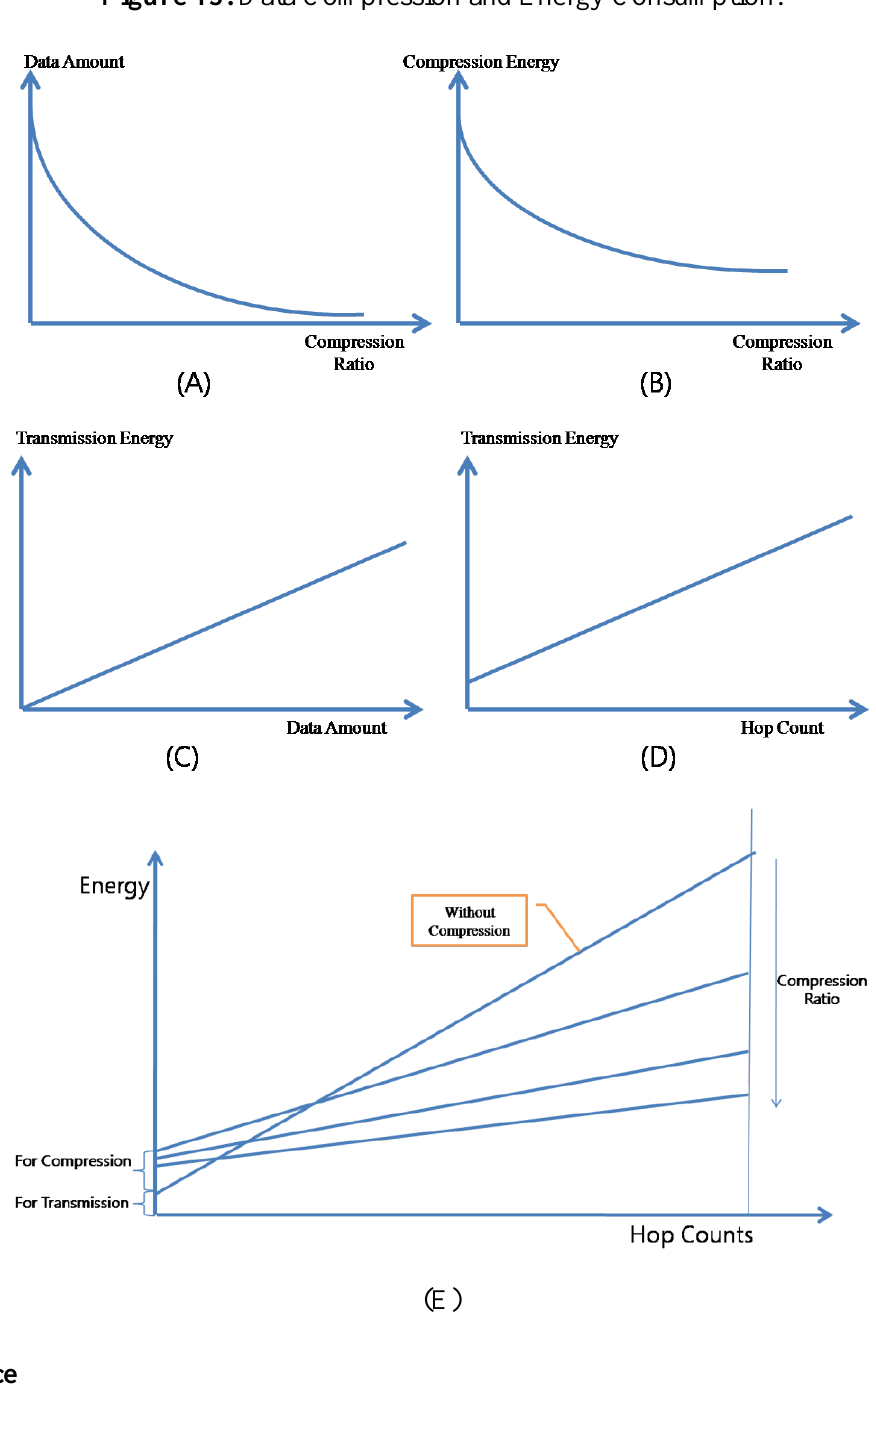
Figure 13. Data Compression and Energy